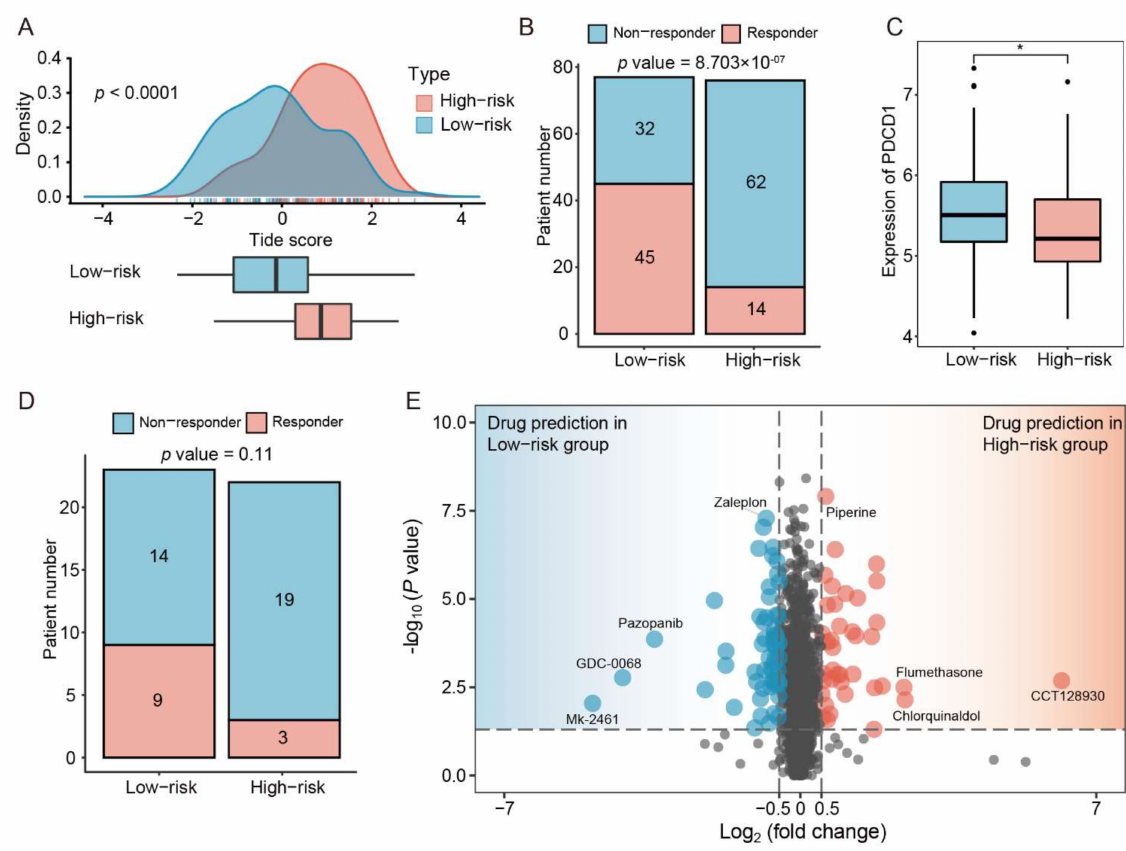
Figure 6. Immunotherapy efficacy accession and potential chemotherapy drugs prediction ( A ) The difference of the tumor immune dysfunction and exclusion (TIDE) score between the high- and low- risk groups. ( B ) Proportion of responders and non-responders in HP+ GC patients based on the result of TIDE algorithm. Statistical significance of difference was determined using Chi-square test. ( C ) The difference of PDCD1 expression between the high- and low-risk groups. * p < 0.05 ( D ) Proportion of responders (CR/PR) and non-responders (SD/PD) in patients treated with anti-PD-1 immunotherapy from the PRJEB25780 cohort. ( E ) Drug candidates with potential therapeutic effect for the low-risk group or the high-risk